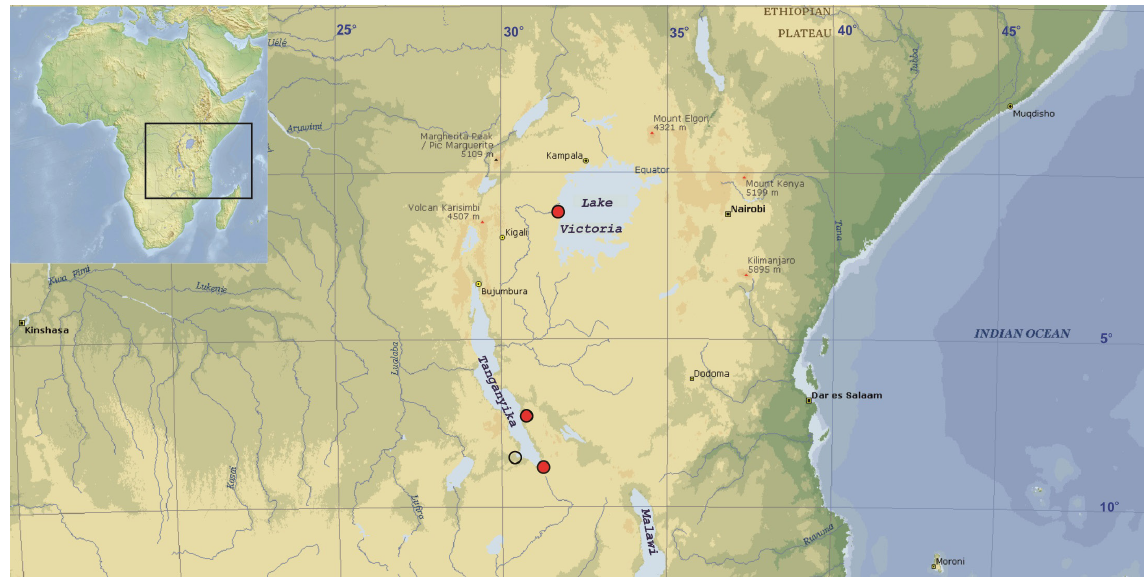
Fig. 11. Verified records of Eucyclops agiloides (G.O. Sars,1909). Filled red circles show occurrences verified by the authors, and open circle shows a record taken from the original description of the species (Sars